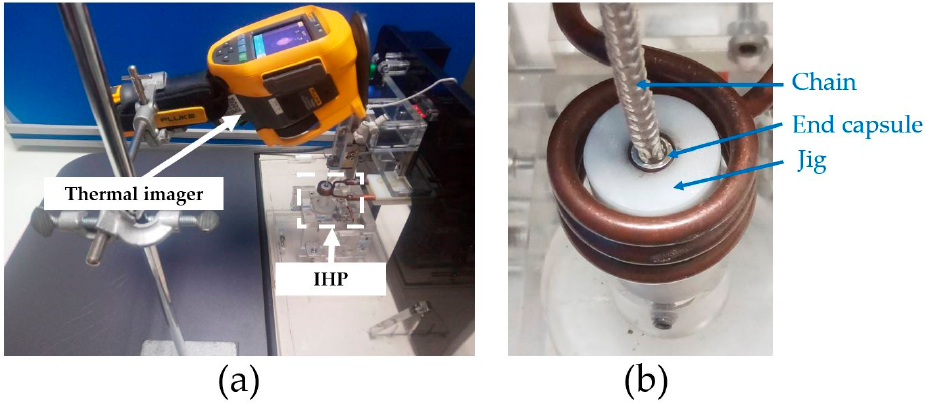
Figure 7. The thermal imager setup, ( a ) an overview, and ( b ) a sample image from the camera screen.